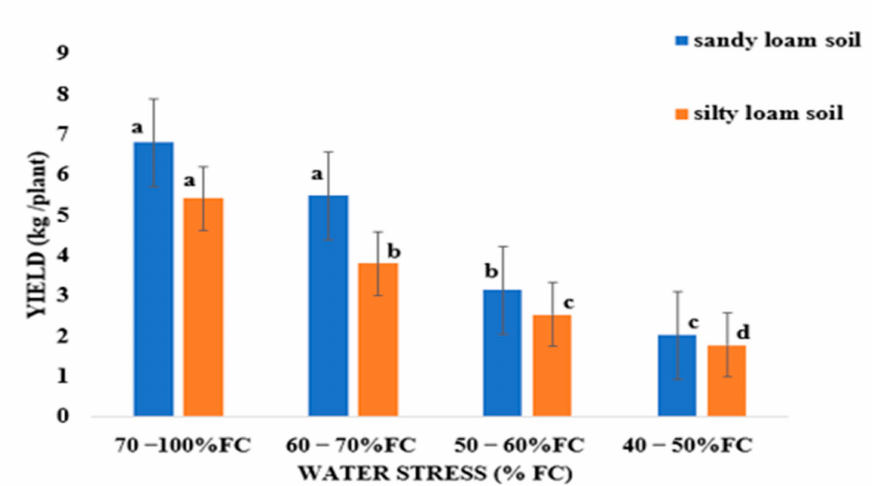
Figure 7. Effects of water stress level and soil type on marketable yield (kg of plant − 1 ) of tomatoes (the same letter indicate no significant